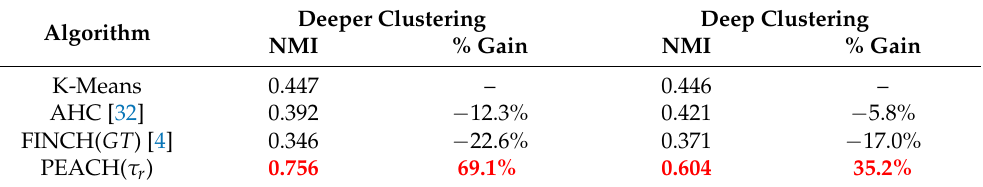
Table 4. PEACH Improves Unsupervised Training. We show the NMI for various clustering algorithms used during the training process of deep clustering, and gains over [10,11], respectively. We mark the best results .